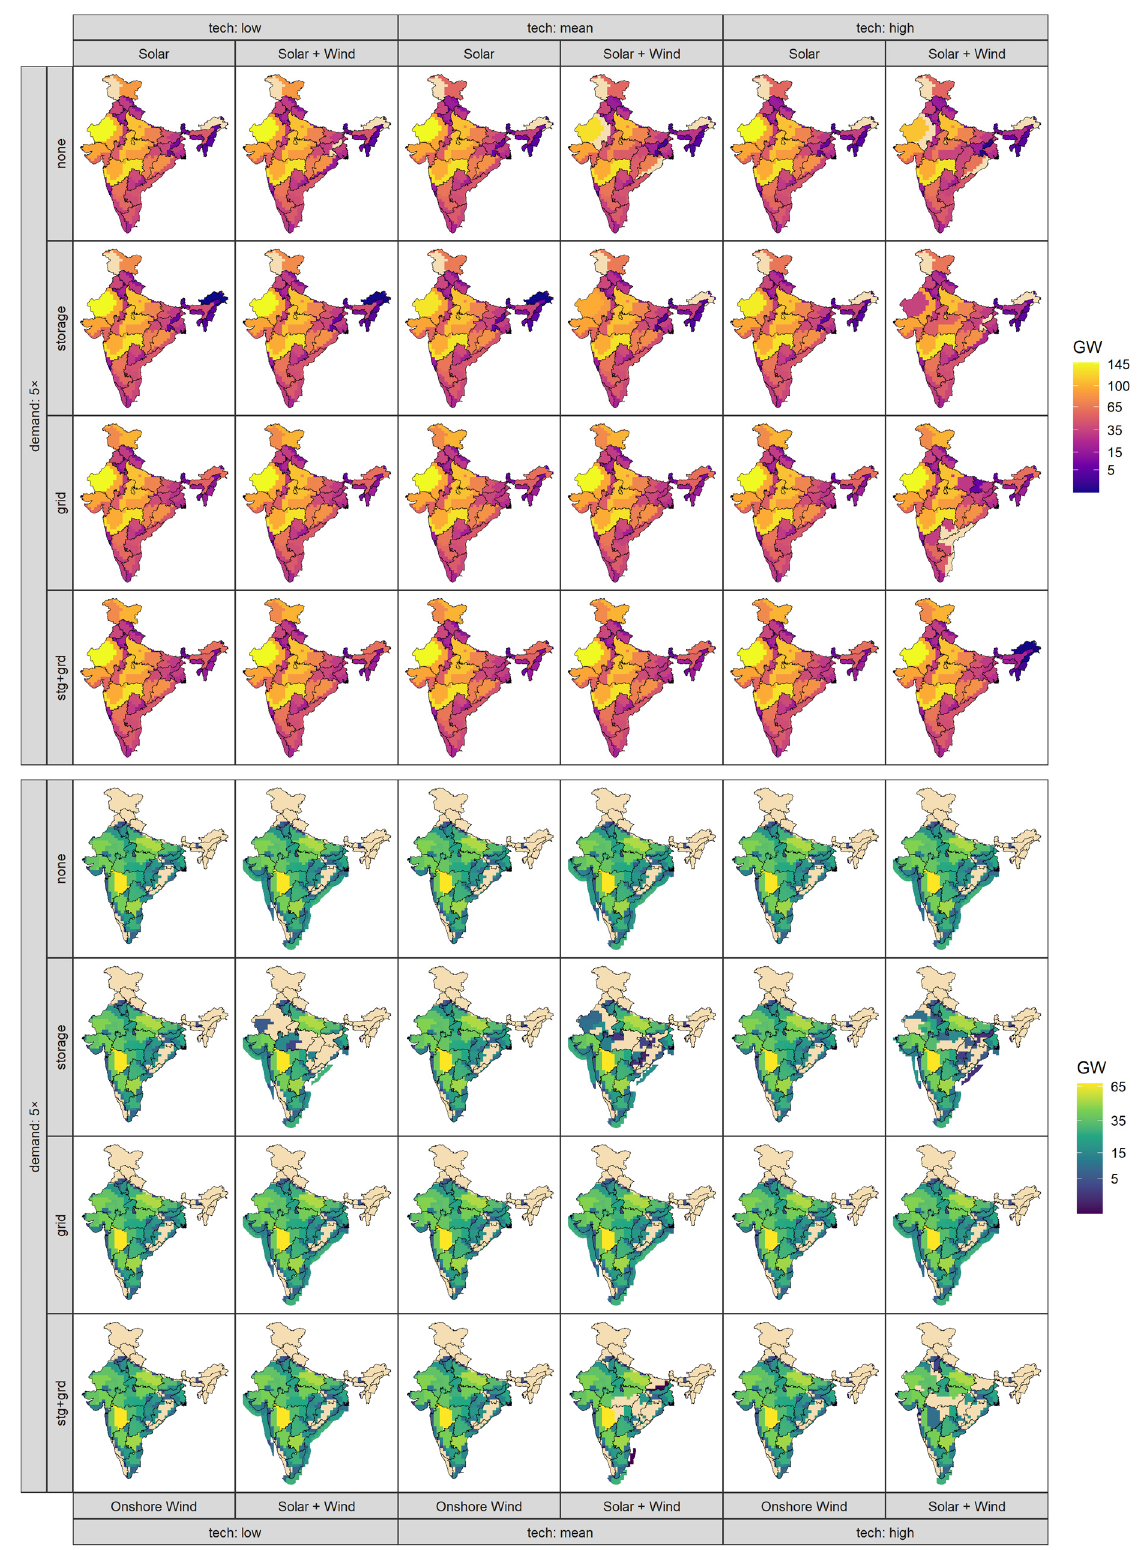
Figure A14. Optimised solar and wind generation capacity by scenarios and clusters, demand level fivefold that of 2019.